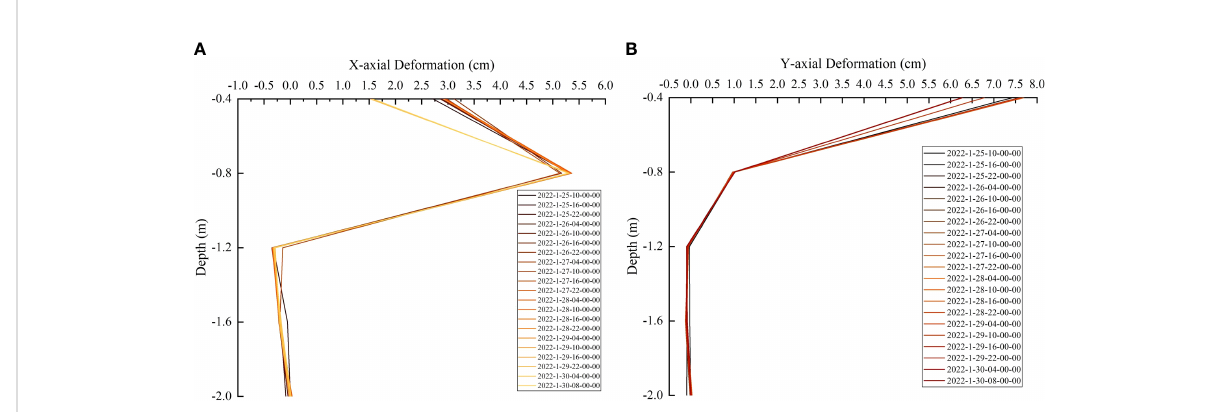
TABLE 5 The maximum and average deformation of the strata. Direction X-axial Y-axial